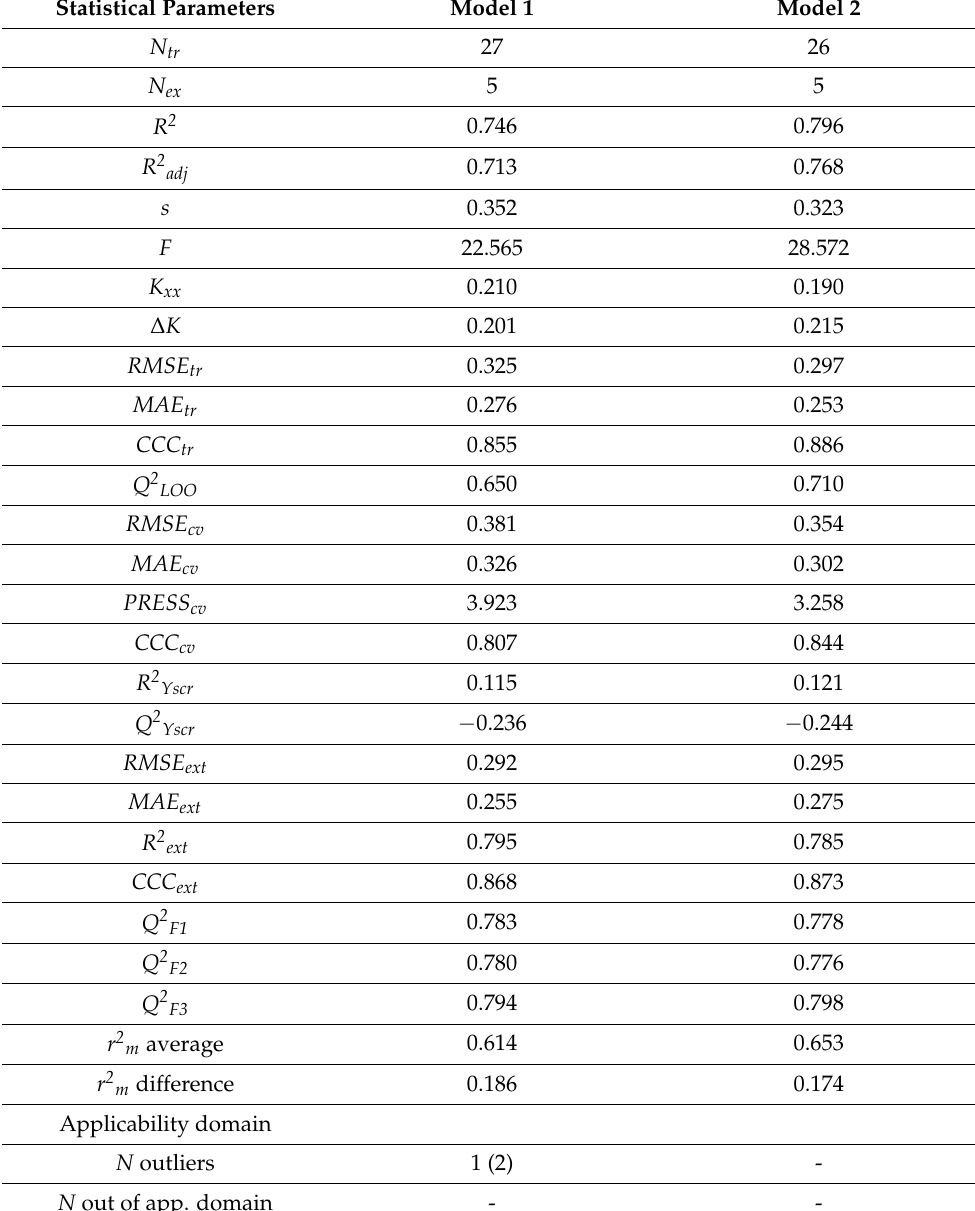
Table S1. Table 2. The statistical parameters for QSAR